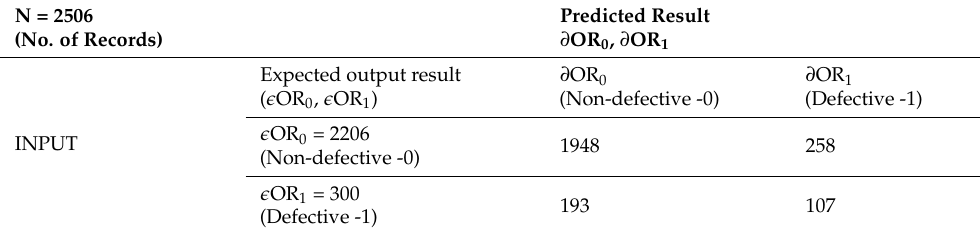
Table 3. NB training.